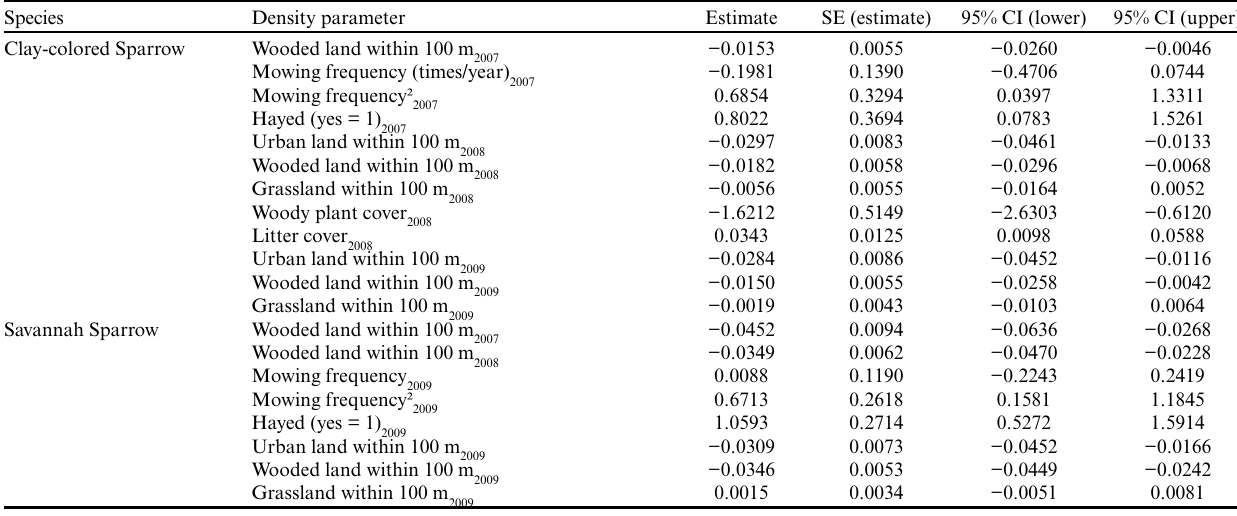
Table 1. Effect sizes and 95% confidence intervals (CIs) for variables from the highest ranking hierarchical distance-sampling models predicting Clay-colored Sparrow and Savannah Sparrow occurrences along 34 transmission line study sites in Winnipeg, Manitoba, Canada in 2007 (34 sites, N = 102 surveys), 2008 (46 sites, N = 138 surveys), and 2009 (44 sites, N = 132 surveys). Models assume a uniform detection probability, and variables with 95% confidence intervals excluding zero are shown. Subscripts indicate year. More detailed results for each species in each year are provided in Appendix 2.